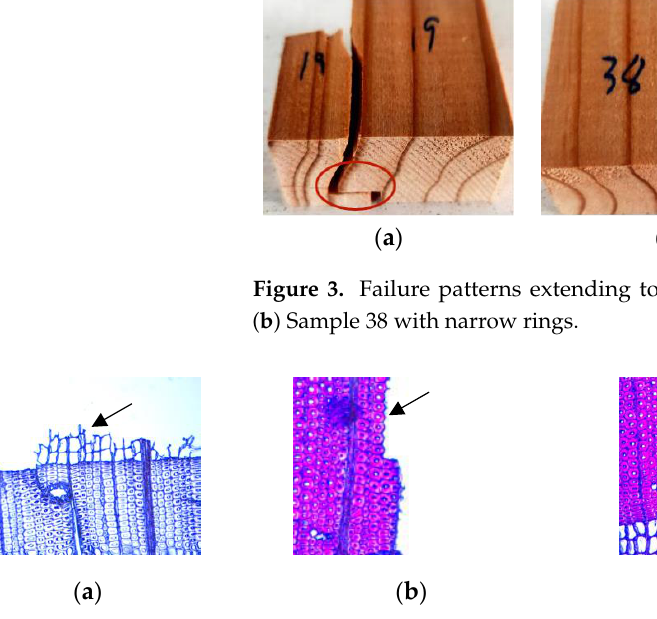
Figure 4. Failure mode under the light microscope. ( a ). The failure mode at the growth ring; ( b ). The failure mode at latewood; ( c ). The failure mode at wood ray; ( d ). The failure mode at earlywood.